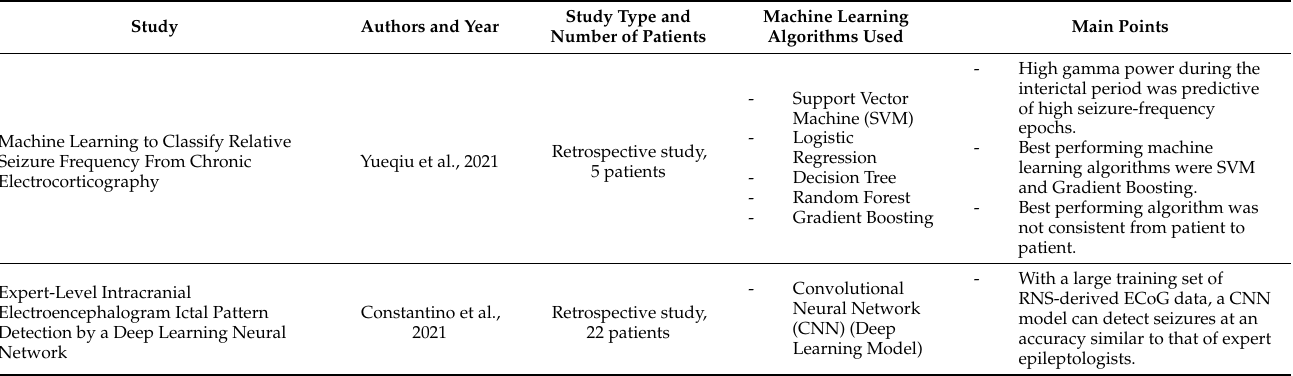
Table 3. Studies Applying Machine Learning Algorithms to RNS-Derived ECoG Data. Major recent studies that have used machine learning algorithms in the context of RNS-derived ECoG data to predict seizure frequency and ictal